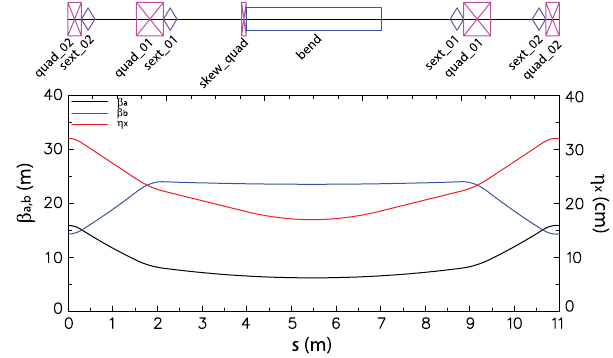
FIG. 2. Horizontal and vertical beta functions β horizontal dispersion function η